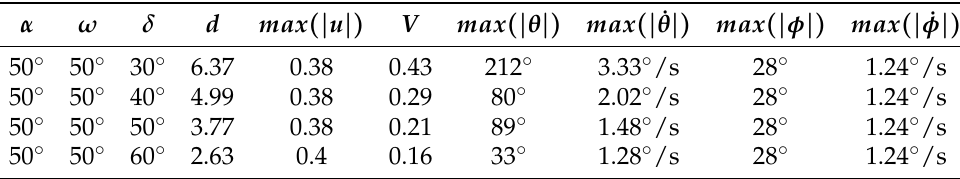
Figure 39. Torque in robot’s joints for δ = 30 ◦ ( a ), δ = 40 ◦ ( b ), δ = 50 ◦ ( c ), and δ = 60 ◦ ( d ). Table 3. Simulation results for different phase shifts δ .